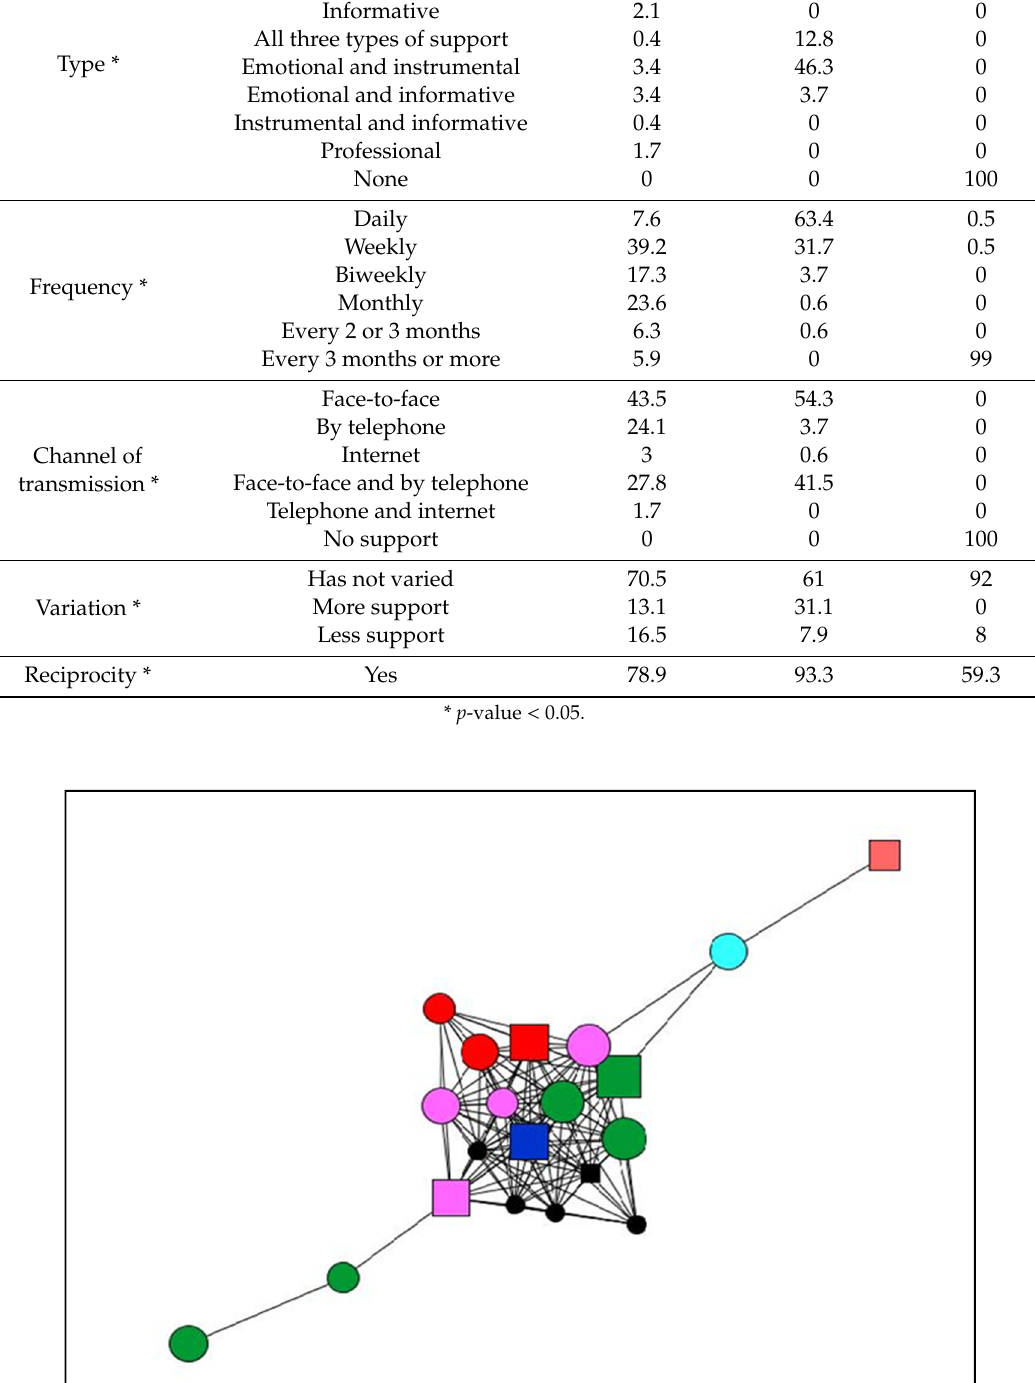
Figure 3. Graph Case 28. Man (66 years old), living with chronic pain for 35 years.